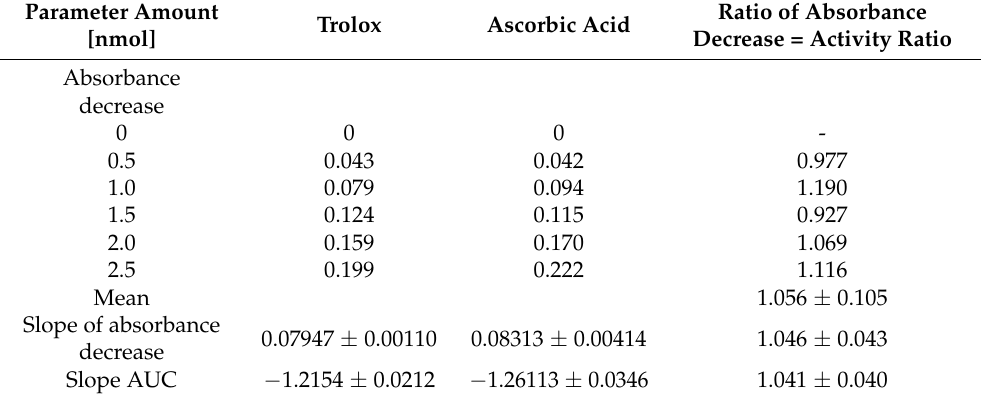
Figure 9. Concentration dependence of ABTS • reduction by ascorbic acid and Trolox (absorbance decrease and AUC after 6 min; absorbance measured every 30 s). Table 2. Antioxidant activity of ascorbic acid with respect to Trolox, based on the decrease of absorbance and slope of dependence of absorbance decrease on the amount of compound.